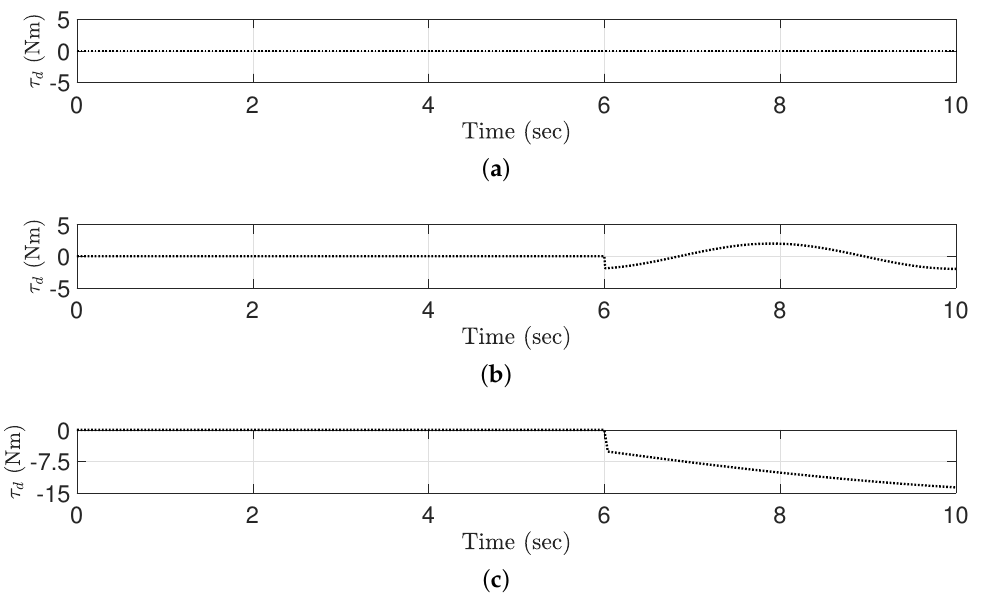
Figure 2. The external disturbances impacted on all axes of quadrotor system: ( a ) without ED (C1); ( b ) with ED (one direction) (C2); ( c ) with ED (anomalous direction)